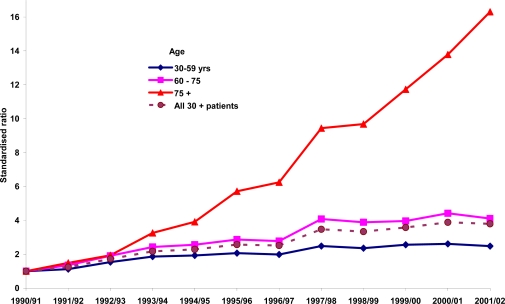
Indirectly standardised PCI ratios for selected age groups: NSW, 1990–91 to 2000–01 (1990–91 specific rates as the standard).